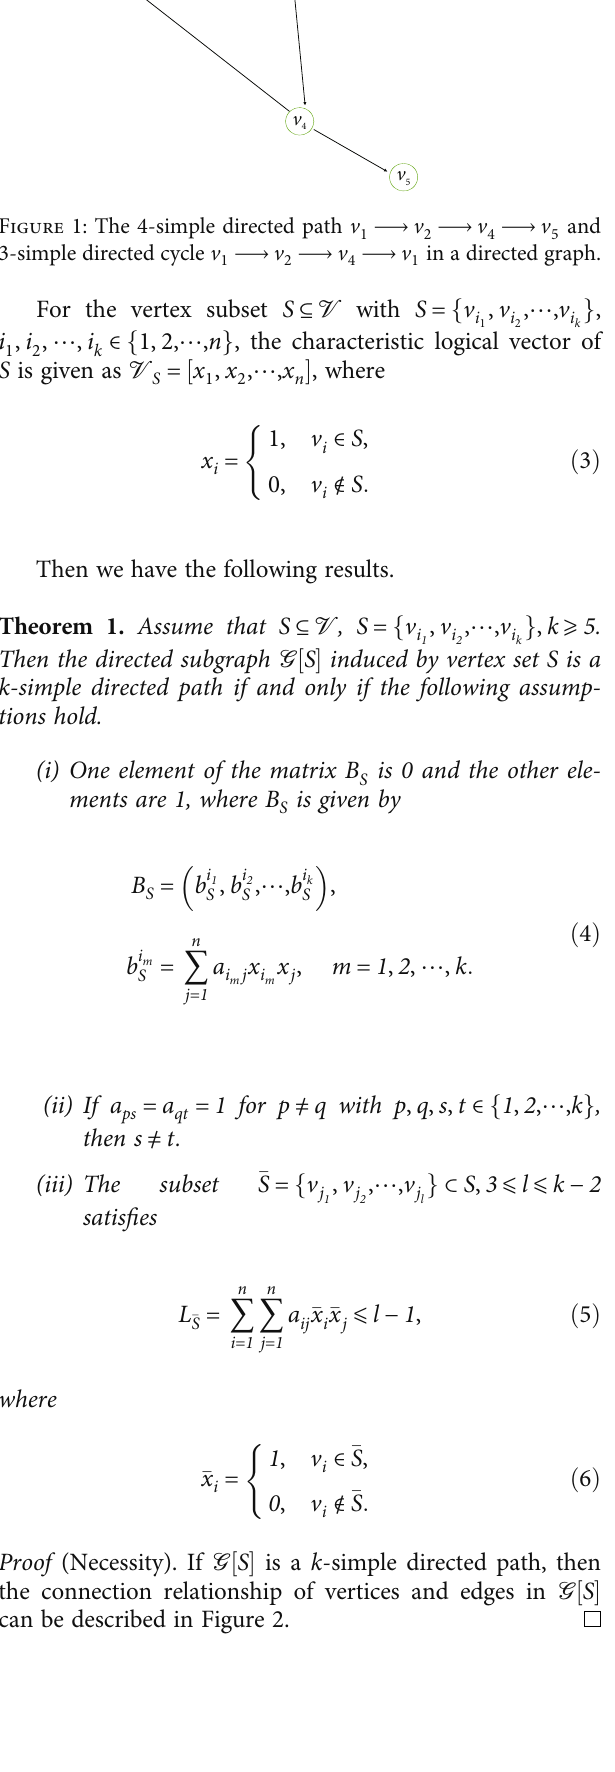
⟶ v ⟶ v ⟶ v 1 2 4 5 and